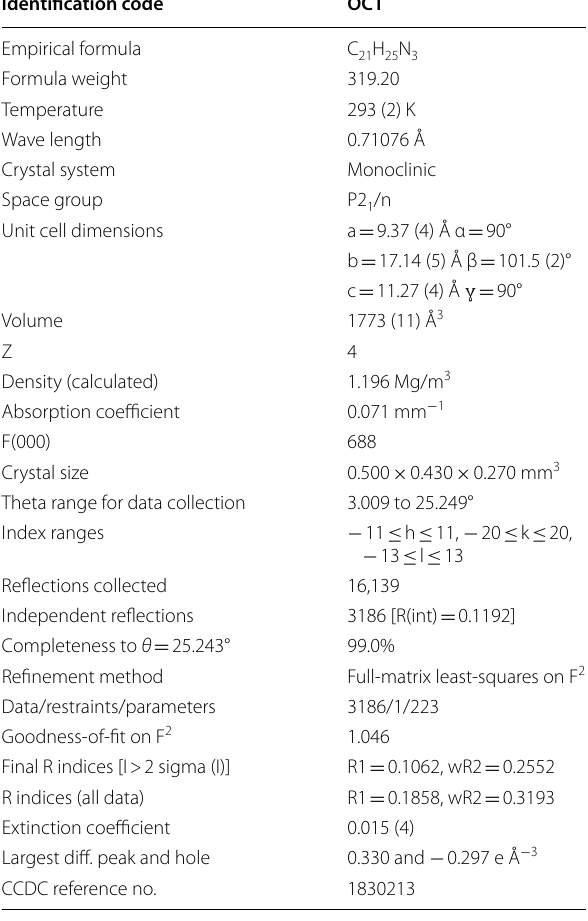
Table 2 Refinement of structure and crystal data